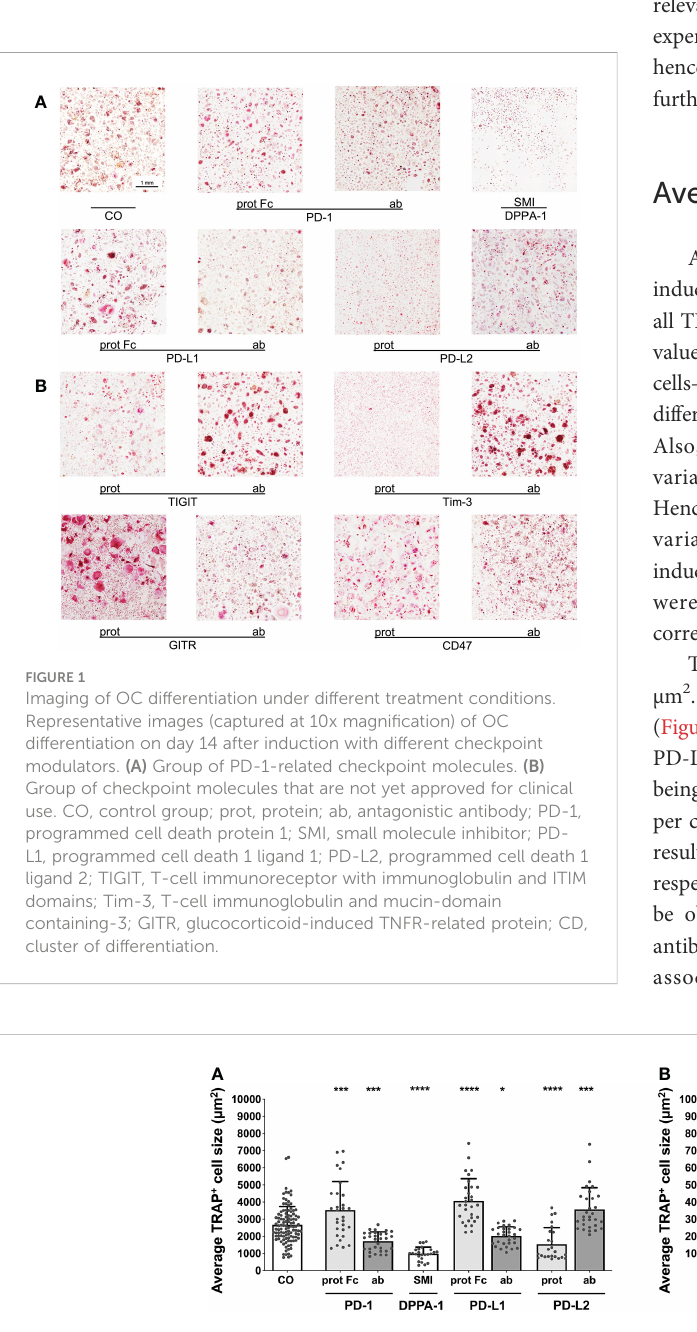
FIGURE 2 Assessment of average TRAP + cell size under different treatment conditions. Average size of TRAP + cells calculated in the six squares (each measuring 1 mm 2 ) per culture well. (A) Group of PD-1-related checkpoint molecules. (B) Group of checkpoint molecules that are not yet approved for clinical use. Each data point represents the mean TRAP + cell size, analyzed in a square of 1 mm 2 , of which 6 were assessed per culture well. Columns show mean and standard deviation. Asterisks indicate level of signi fi cance in comparison to CO, set at P < 0.05 (* < 0.05, *** < 0.001, **** < 0.0001; ns, non- signi fi cant). All data is acquired from at least 3 independent experiments, each with a minimum of 2